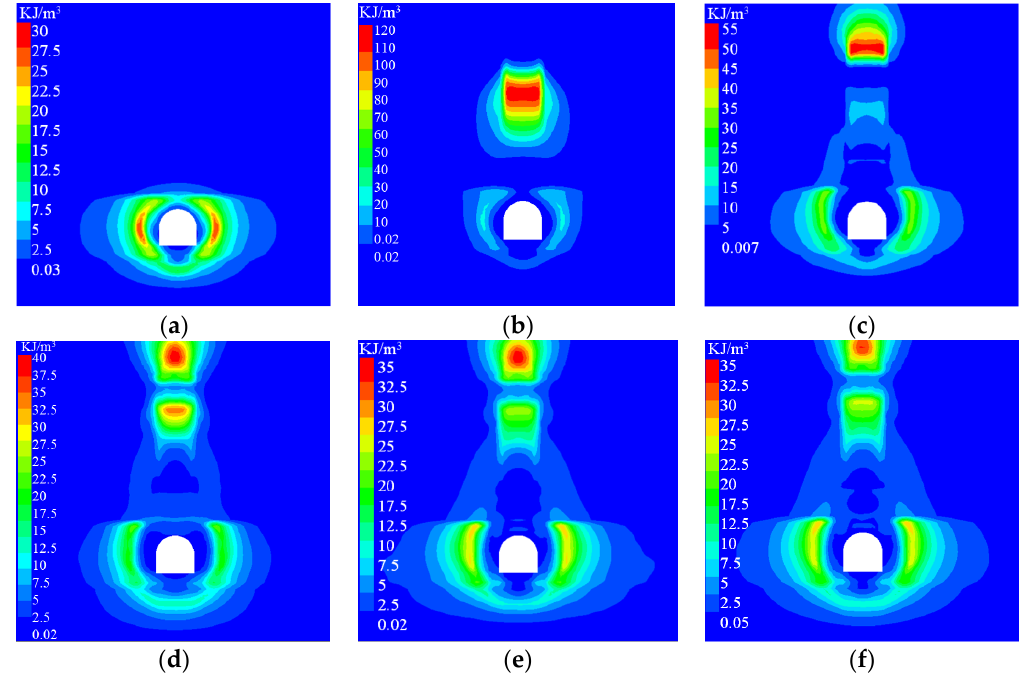
Figure 5. Evolution Nephogram of the Distortion Energy of Surrounding Rock under Dynamic Load Disturbance. ( a ) before dynamic load disturbance; ( b ) dynamic load disturbance of 0.01 s; ( c ) dynamic load disturbance of 0.03 s; ( d ) dynamic load disturbance of 0.05 s; ( e ) dynamic load disturbance of 0.07 s; ( f ) dynamic load disturbance of 0.09 s.